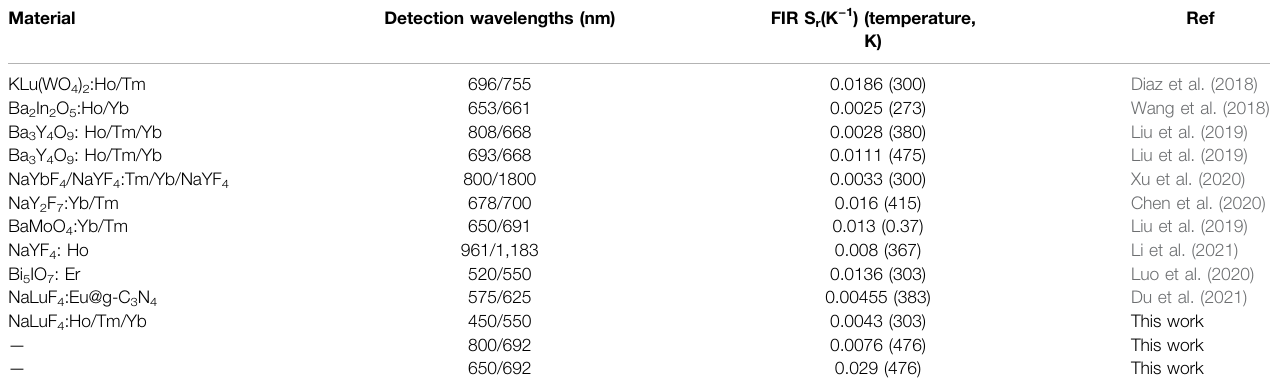
TABLE 1 | Comparison of sensing sensitivities in FIR thermometry.